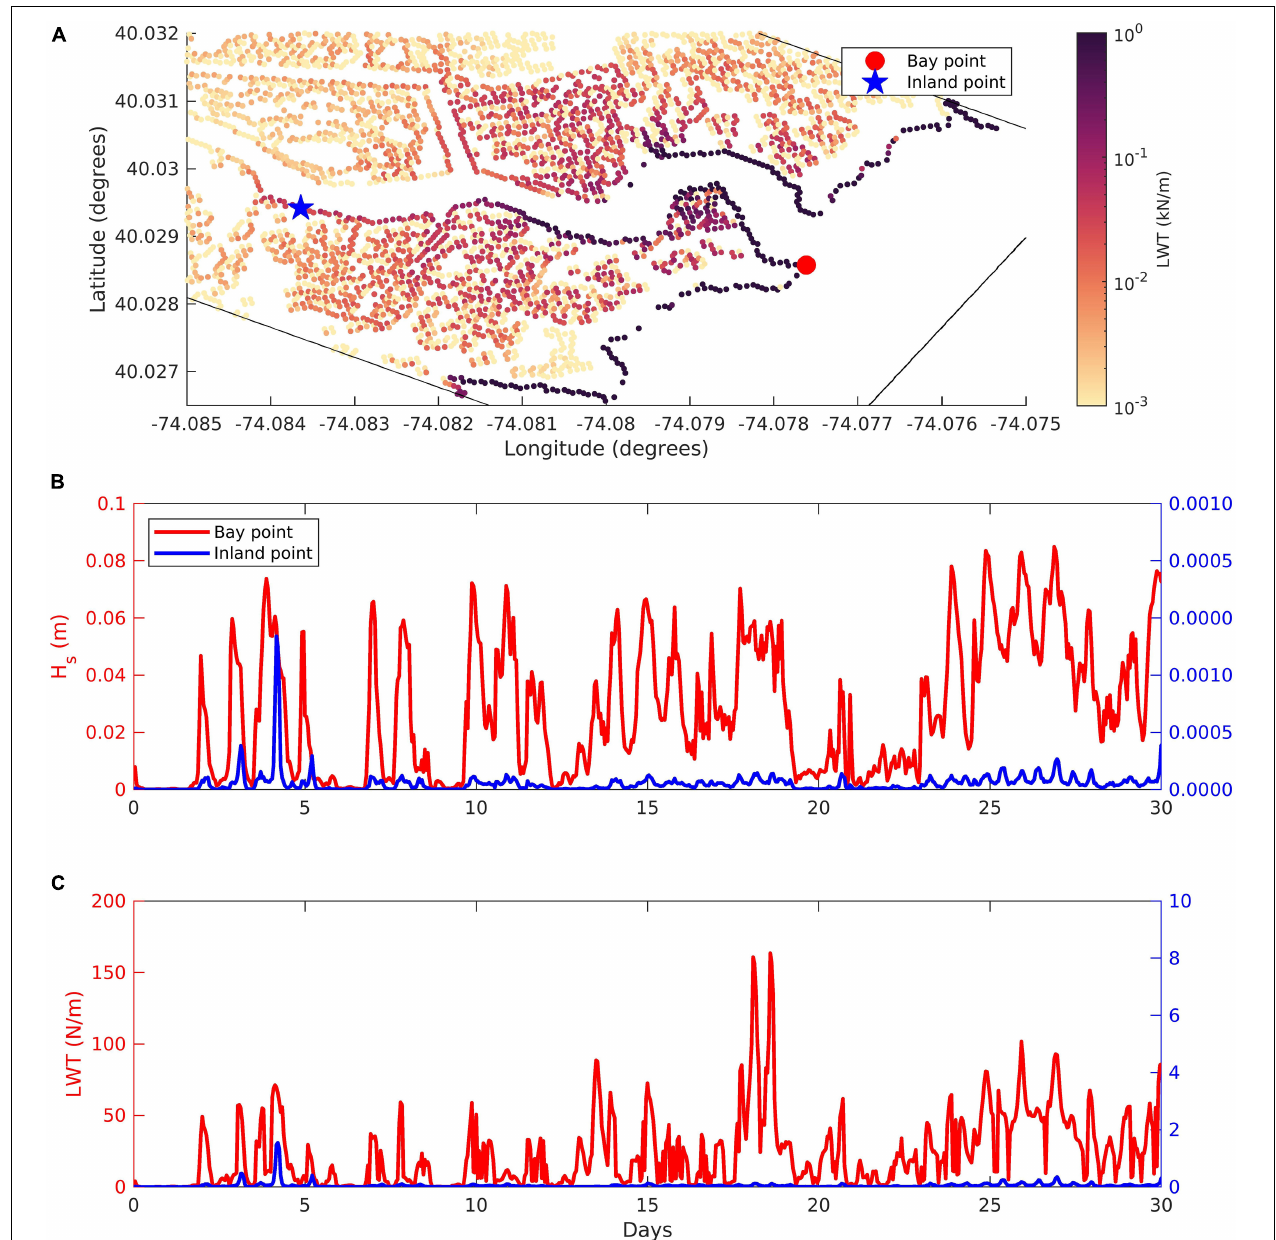
FIGURE 8 | (A) Reedy Creek domain showing integrated lateral wave thrust (LWT) and indicating the location of bay (red circle) and inland points (blue star) for the time series plots of (B) significant wave height ( H s ) and (C) lateral wave thrust (LWT). The left “ y ” axis in figs. (B,C) correspond to bay point and right “ y ” axis corresponds to the inland